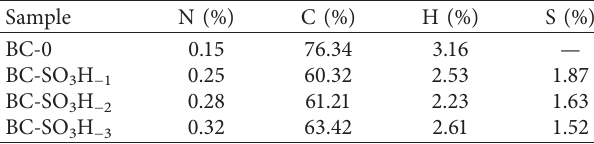
Table 2: Chemical composition of raw corncob.